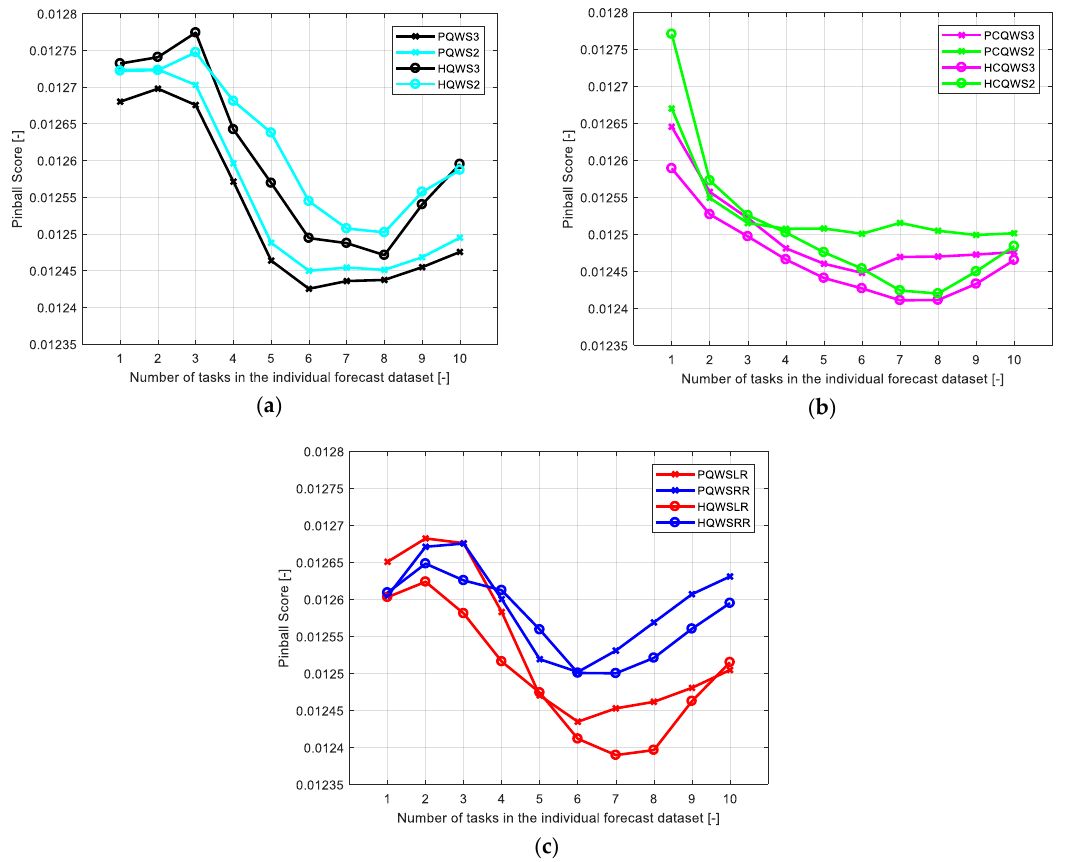
Figure 5. Pinball Score values of combined forecasts for the zone 1: ( a ) PQWS2, PQWS3, HQWS2, and